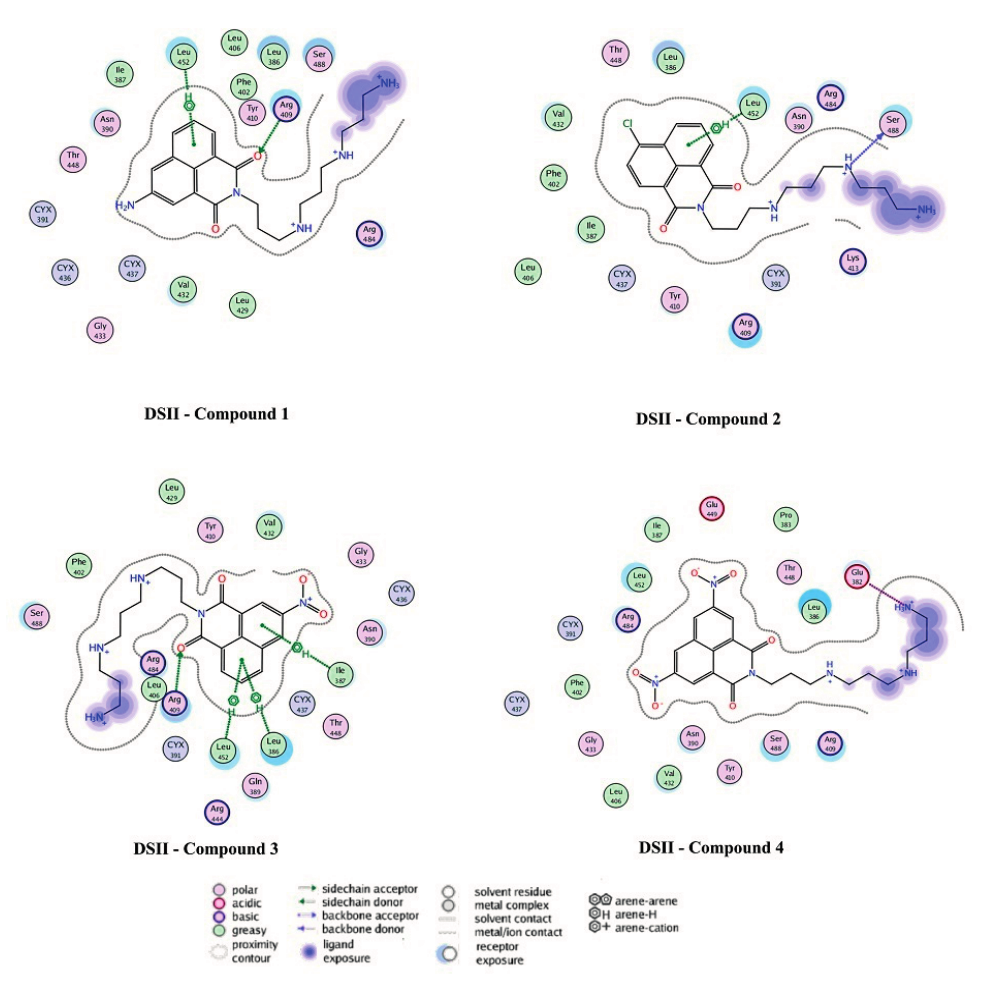
Figure 14. Docking experiment results showing the 2D diagrams of the binding modes of the complex DSII-compounds 1 – 4 . Polar and nonpolar residues were represented in the red and green circles, respectively. H-bond acceptors or donors were shown in green-dotted arrows. Electrostatic interactions from ion pairs were presented in red-dotted lines. π - π and π -H interactions were represented in green-dotted